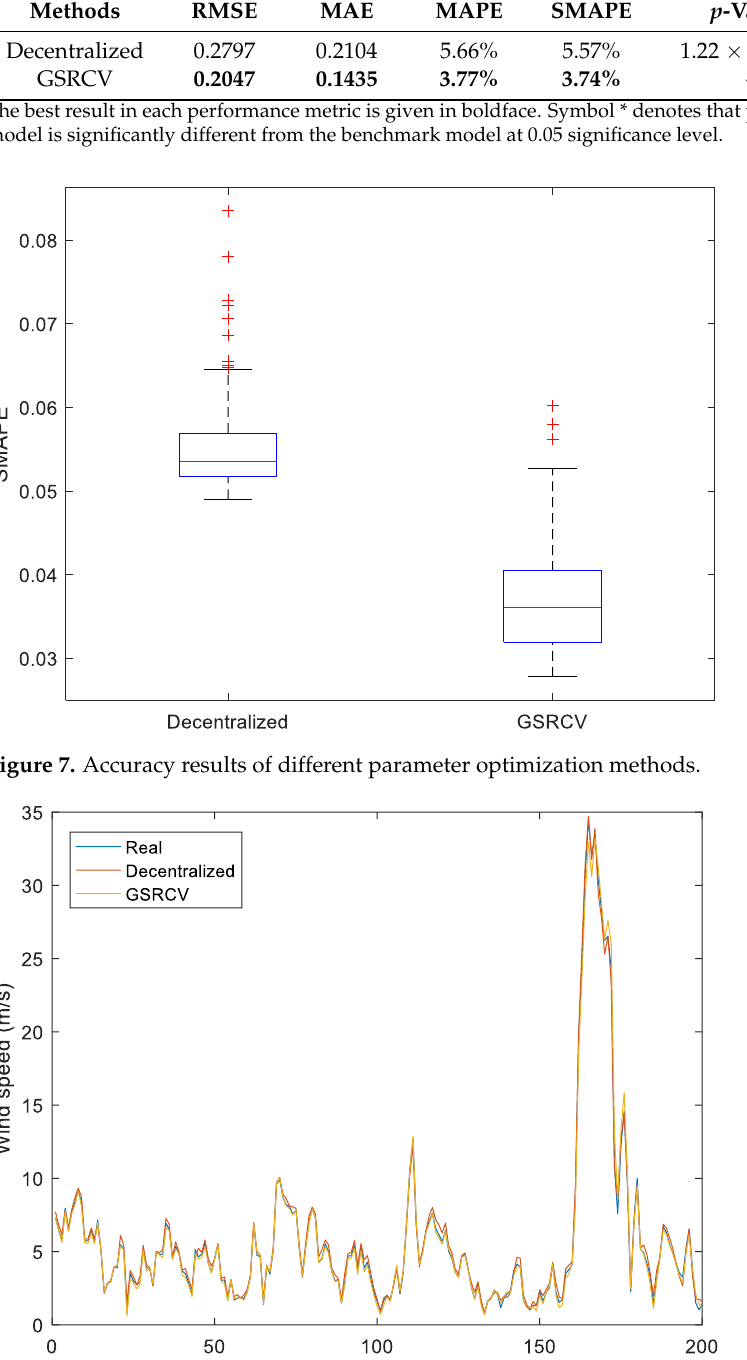
Table 3. Parameter selection results of different optimization methods.